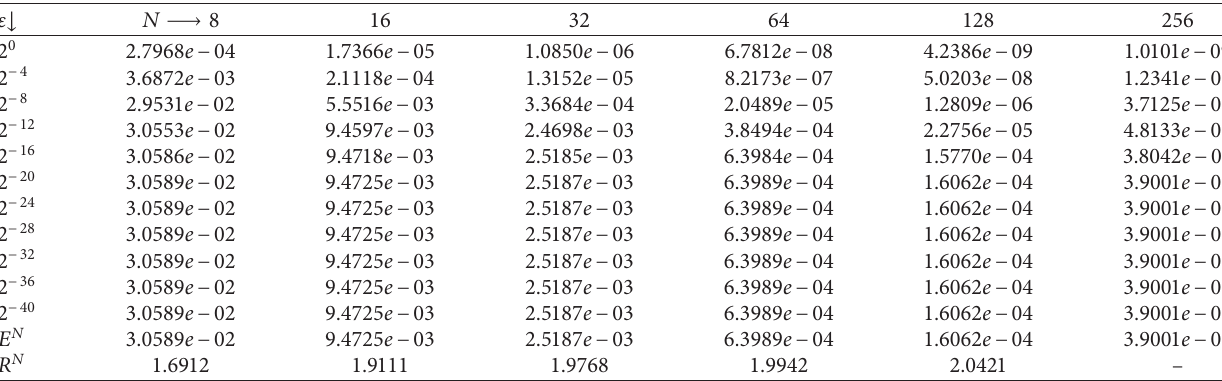
Table 6: Maximum absolute error of Example 3 after Richardson extrapolation for δ � 0 . 6 ε and η � 0 . 5 ε .